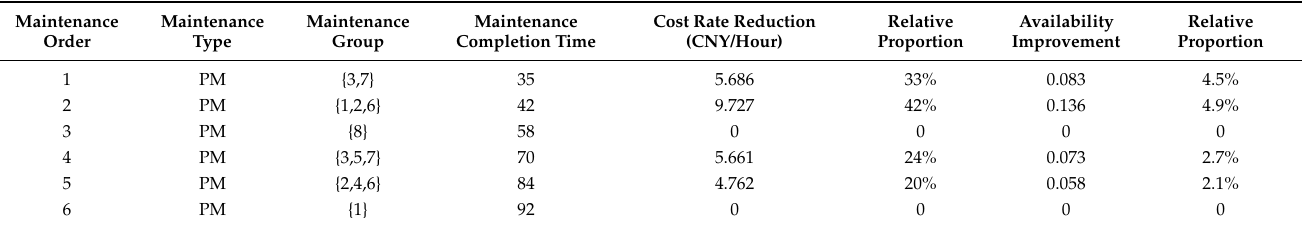
Table 3. Optimal system-level PM plans under ∆ A control = 0 in 100